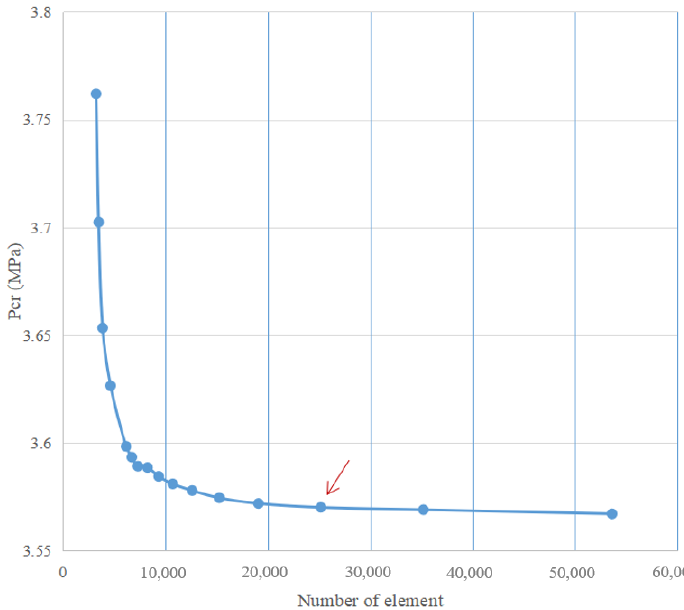
Figure 2. Mesh sensitivity analysis for composite cylindrical shell.